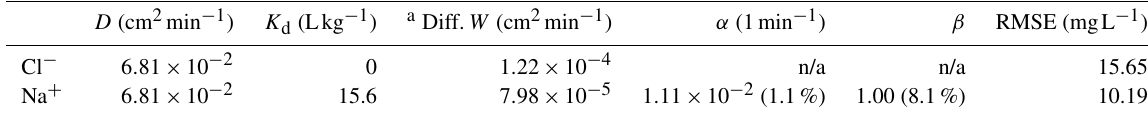
Table 4. Unsaturated transport parameters used in or estimated by HYDRUS and models’ goodness of fit data. “n/a” – not applicable. Estimated values are presented with the coefficient of variation as percentages in brackets. “Diff. W ” is the molecular diffusion coefficient of the solutes.